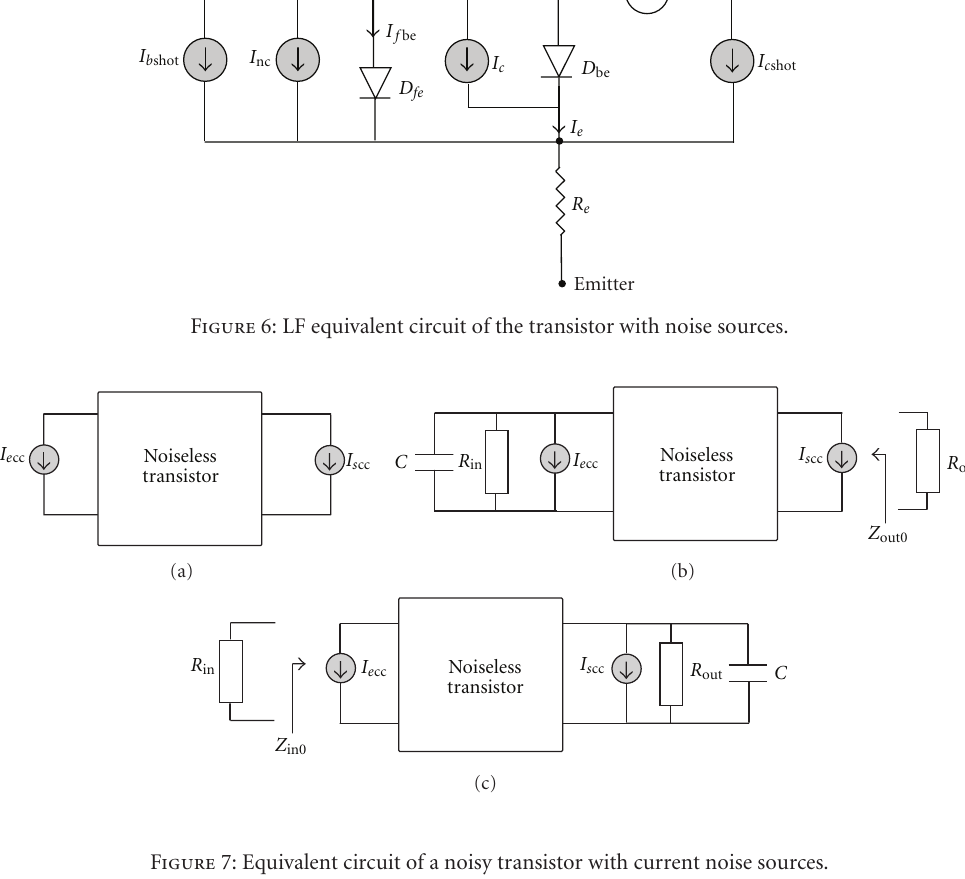
Figure 7: Equivalent circuit of a noisy transistor with current noise